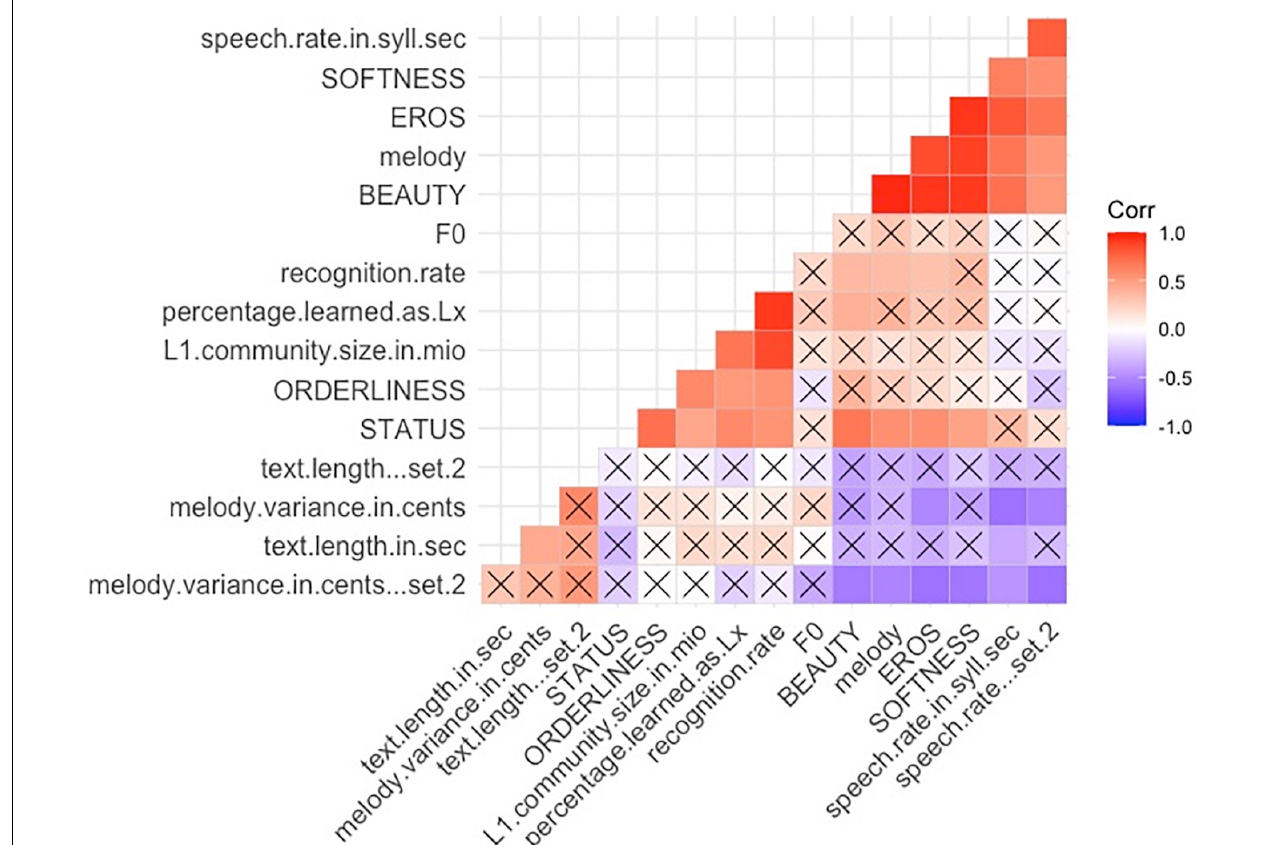
FIGURE 5 | Zero Order (Spearman) Correlations Matrix Overview of all variables, p < 0.1 ( p level was set to include trend-level correlations. For the chart displaying all correlation coefficients at p < 0.1 trend , p < 0.05*, and p < 0.01** level see Supplementary Material Table S2 ).